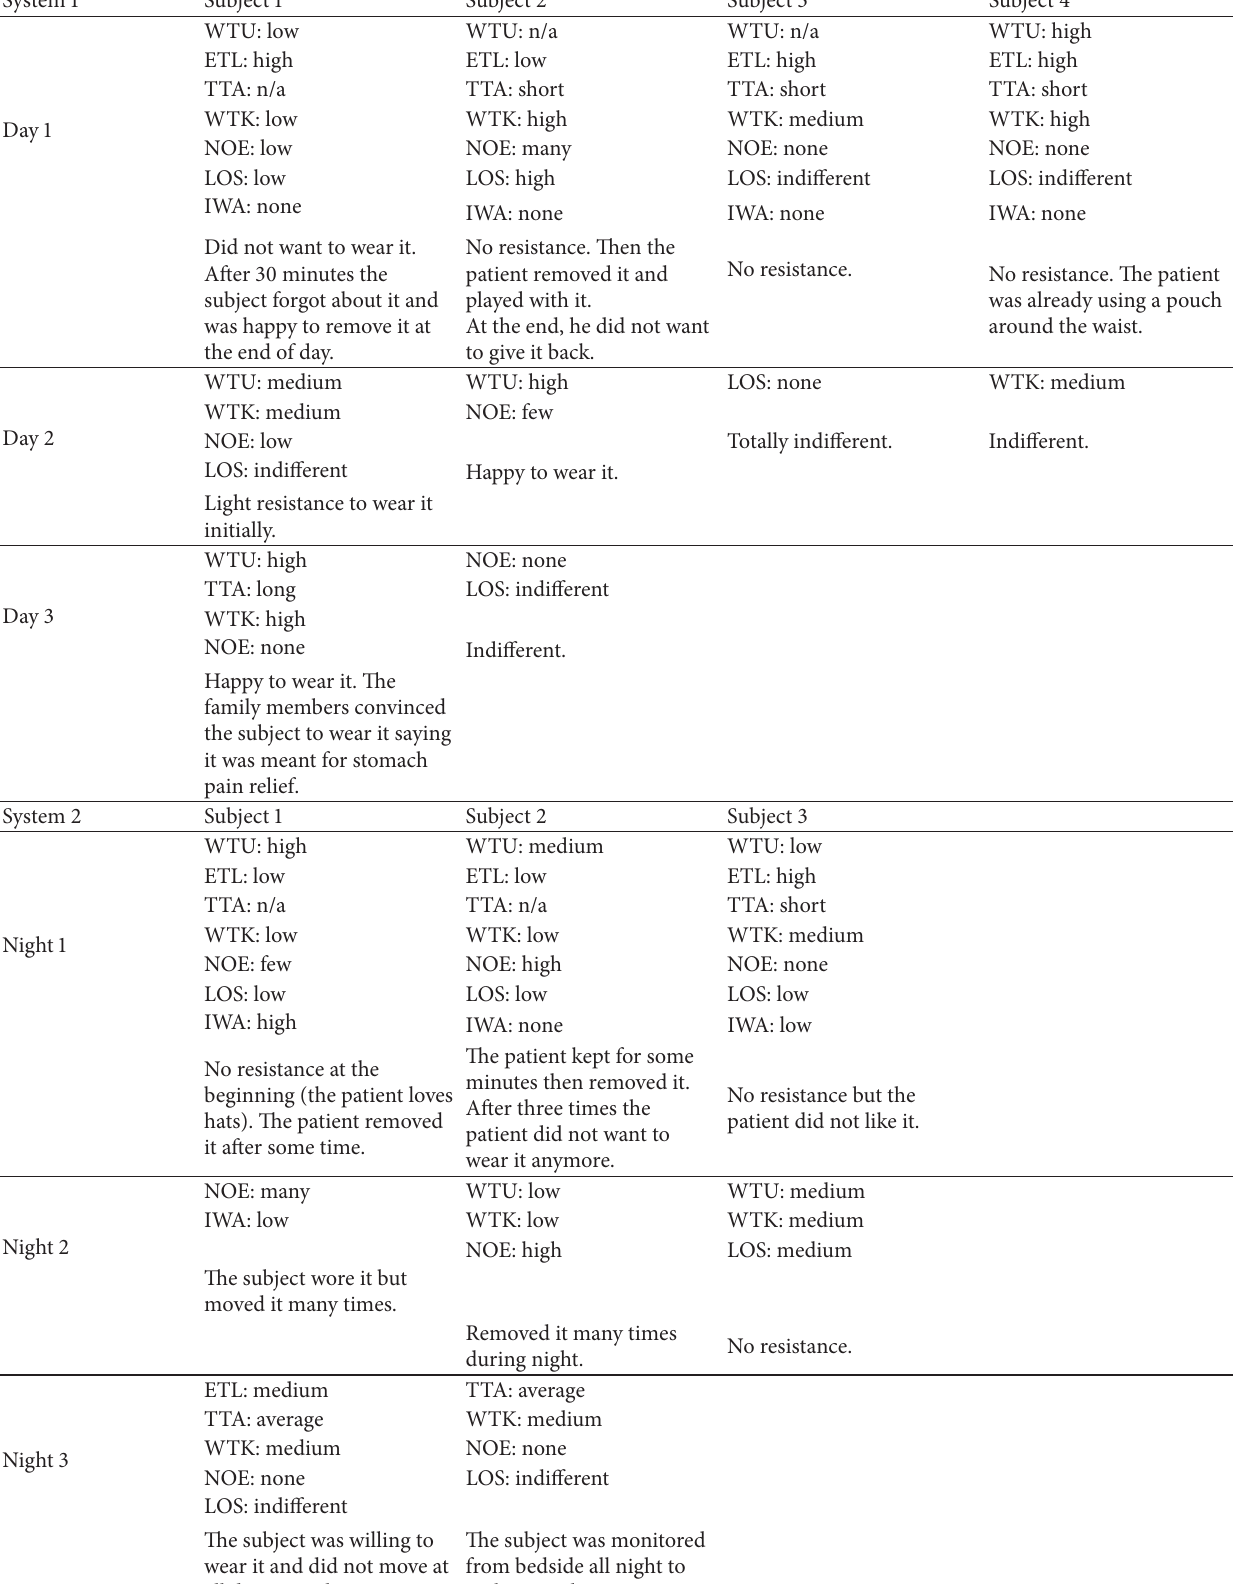
Table 2: Behavior of the subjects towards new monitoring